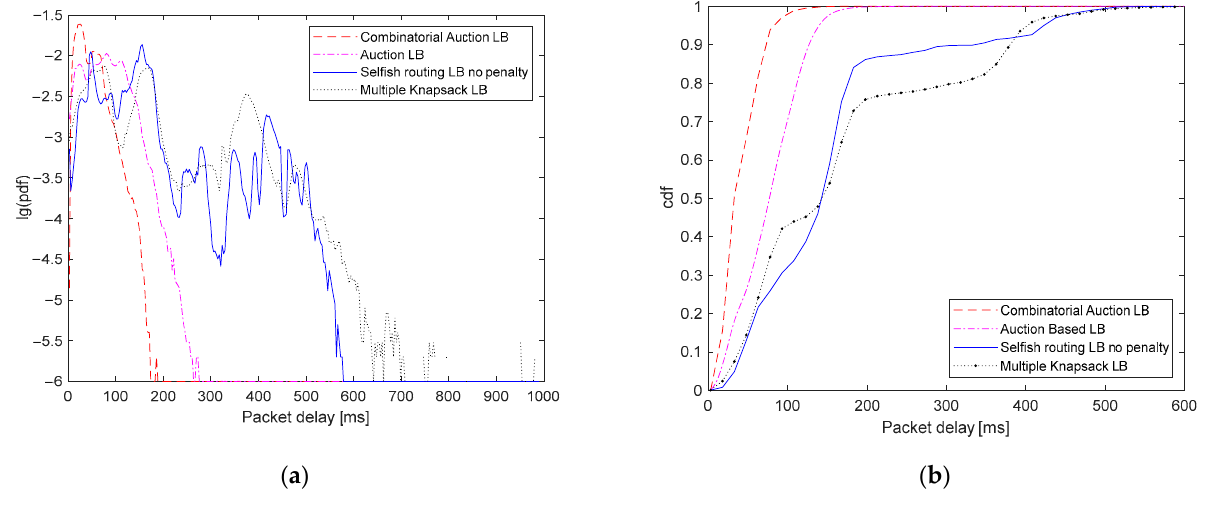
Figure 11. Statistical characterization of the packet delays inserted by the bests of the considered LB algorithms: ( a ) The pdfs of the packet delays; ( b ) The cdfs of the packet delays. Table 3. Values of the packet delay cdfs for the LB algorithms considered in Figure 11. LB